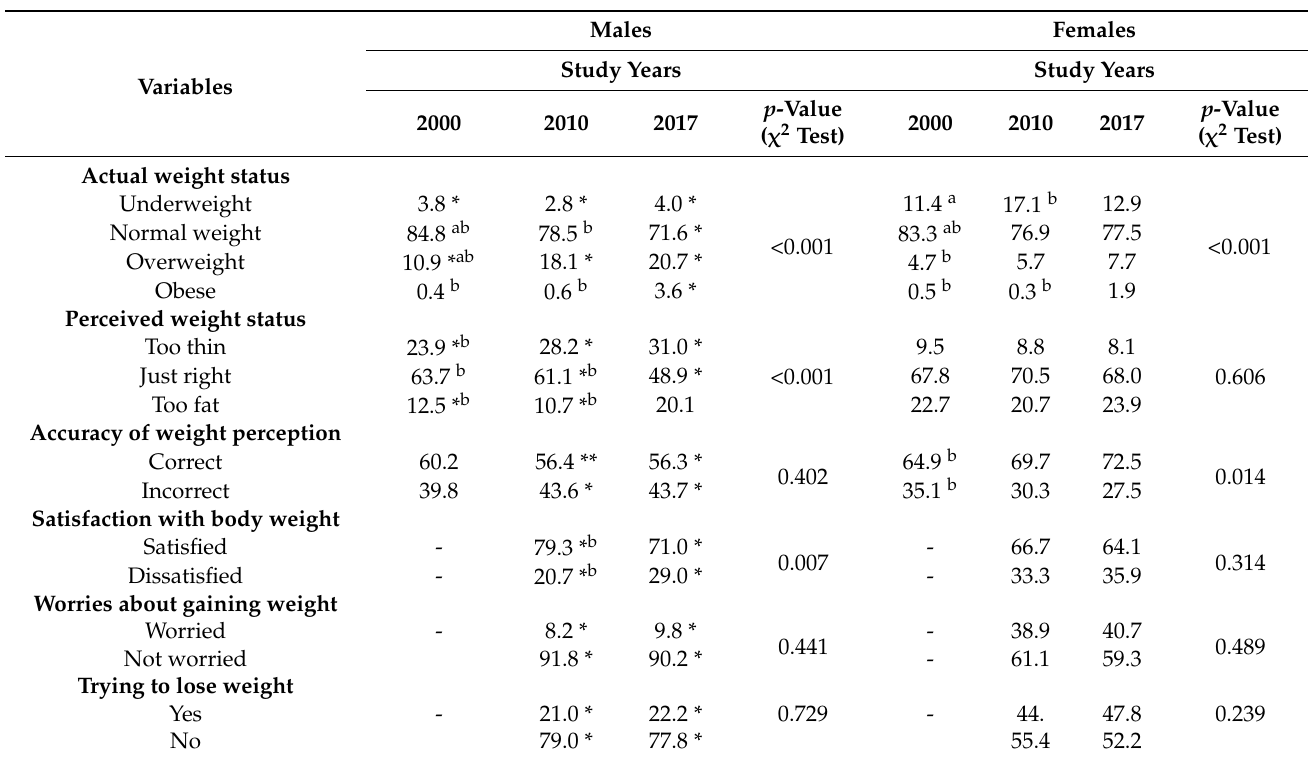
Table 2. Distribution (%) of students by weight status, weight perception, satisfaction with body weight and weight control in 2000, 2010 and